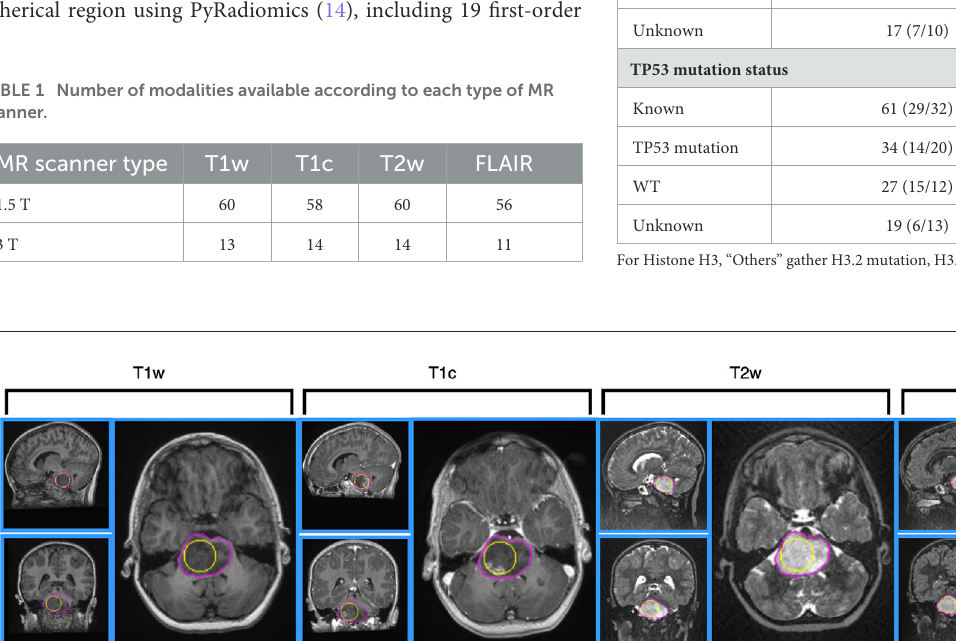
Sagittal Axial layout (cid:12) (cid:12) Coronal (cid:12)